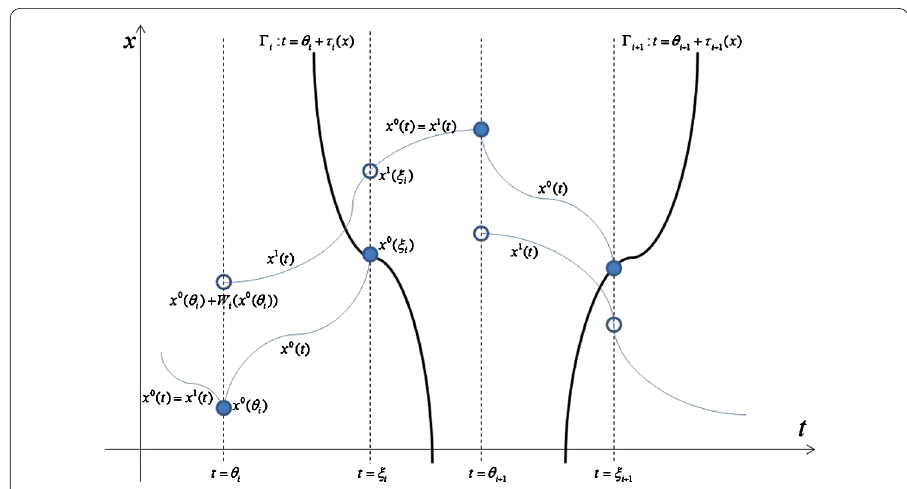
Figure 1 Construction principle of the map W i ( x 0 ( θ i